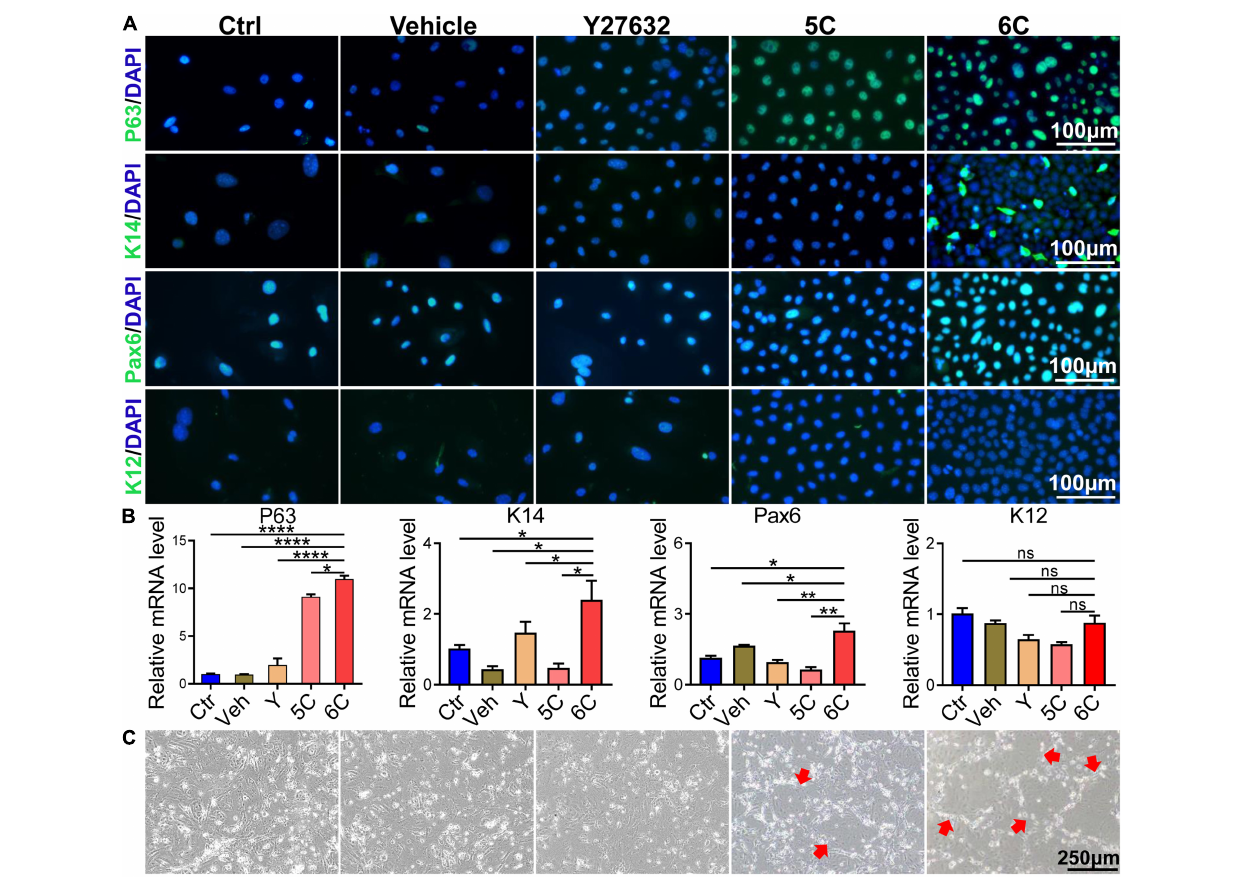
FIGURE 3 | 6C can effectively maintain the expression of primary mCEC related genes. (A) Immunofluorescence staining of mCEC function markers (green). Nuclei were stained with DAPI (blue). P63 and K14 are markers representing the characteristics of corneal epithelial stem cells. Pax6 is a key transcription factor regulating corneal epithelial cell fate. K12 is a marker of mCEC differentiation. (B) qRT-PCR analysis of P63 , K14 , Pax6 and K12 gene expression (normalized to ctrl). Data expressed as the means ± SEM from three separate experiments (* P < 0.05, ** P < 0.01, **** P < 0.0001, ns: no significance). (C) 6C can promote the formation of clones of mCEC (red